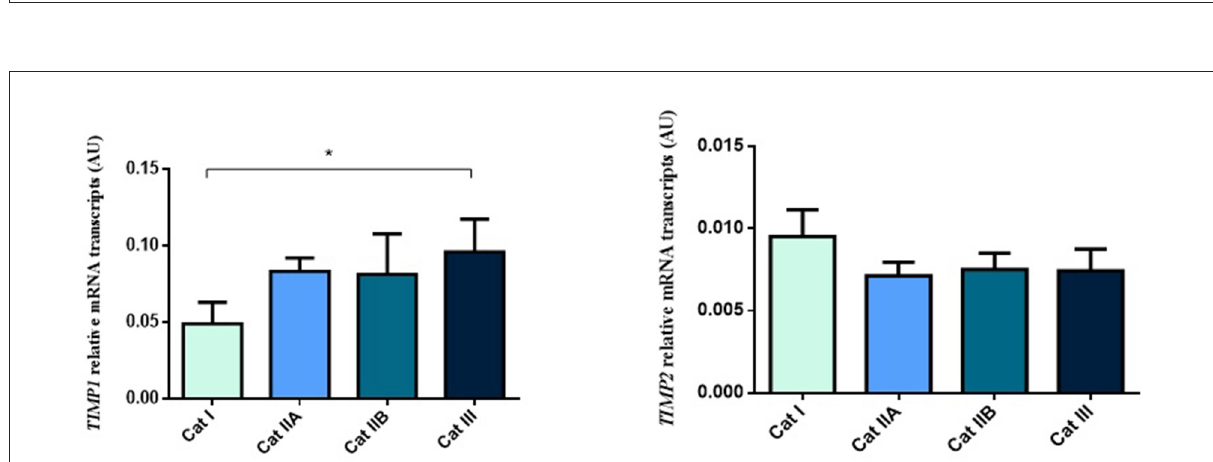
FIGURE3 Relative TIMP1 and TIMP2 transcripts in equine endometrium graded as Kenney and Doig’s categories I, IIA, IIB and III. Bars represent mean ± SEM. The asterisk indicates significant differences between endometrial categories (* P < 0.05).